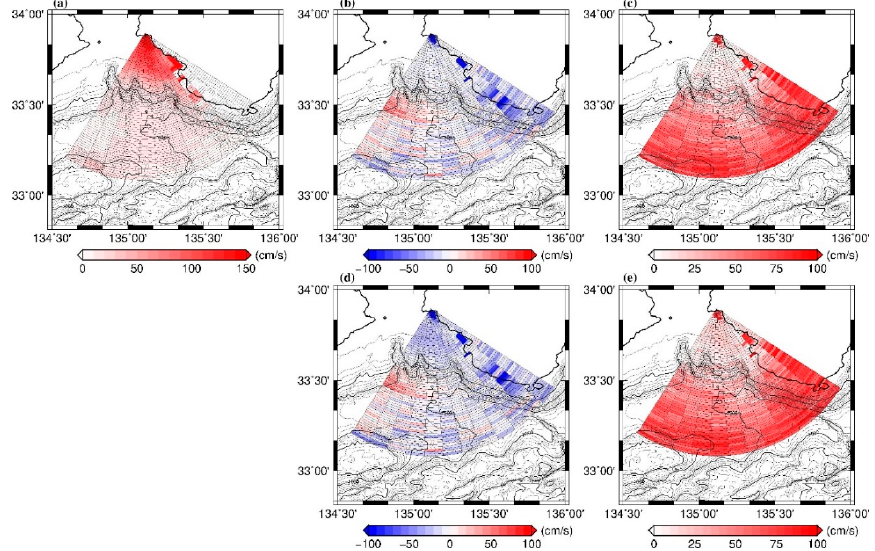
Figure 5. Same as Figure 4, but for the 02271300 scenario.